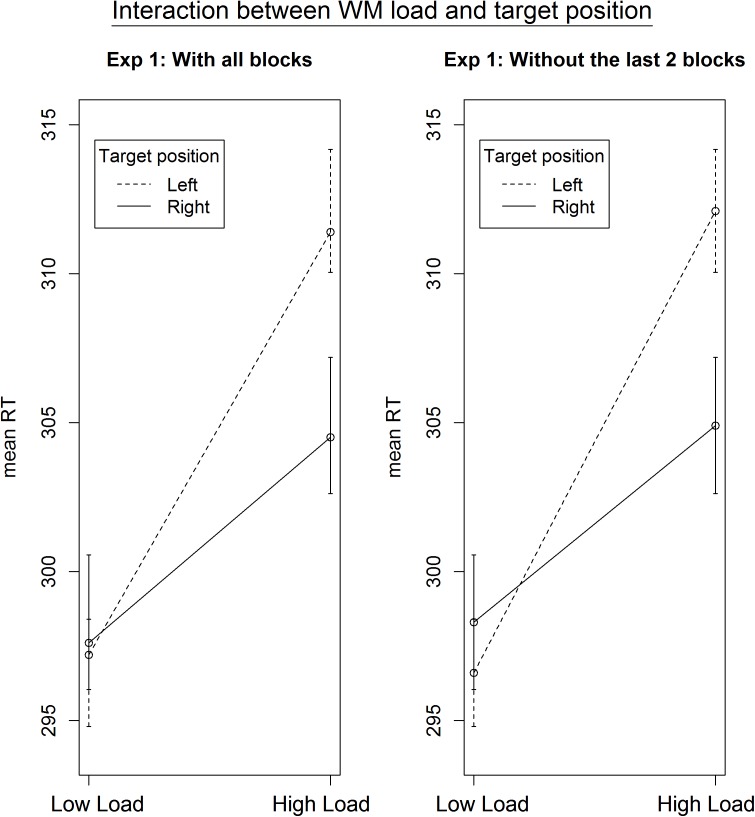
Average RTs as a function of target position and load (Experiment 1). The left panel represents all blocks, the one on the right only those where we could ensure that the WM manipulation was effective. The interaction between WM load and target position only becomes significant (from p = 0.07 to p = 0.049) when excluding the last two blocks from analysis. The effect of load is larger for stimuli presented in the left vs the right hemispace.